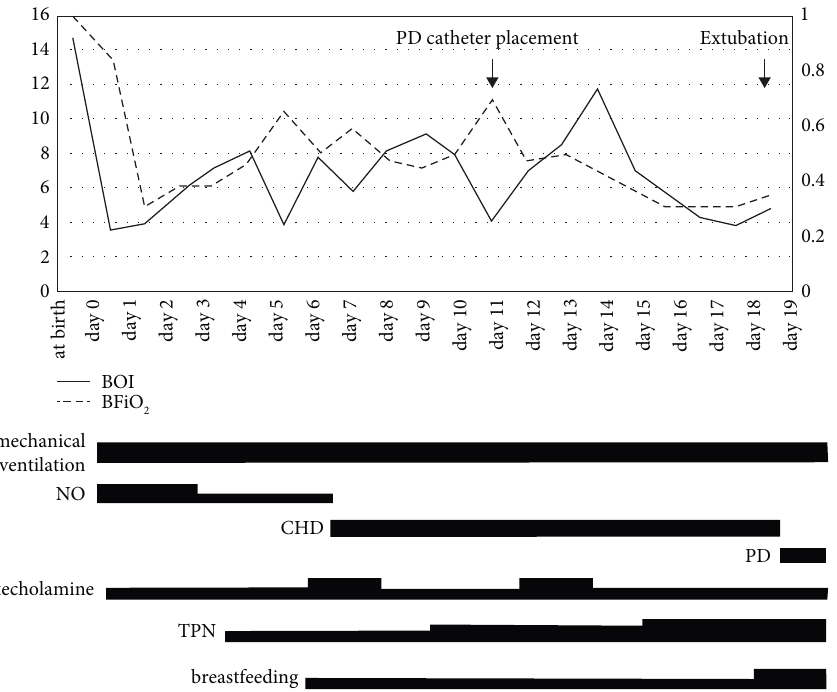
Figure 1: Clinical course immediately after birth. After birth, the patient underwent tracheal intubation and was mechanically ventilated. Systemic management with NO and catecholamines gradually improved OI and FiO 2 . At 5days of age, NO was terminated, and CHD was started. Enteral nutrition started with breast milk at 4days of age, but did not progress, so TPN gradually increased. PD catheter placement was performed at 11days of age. At 18 days of age, CHD was switched to PD and extubated at 19days of age. OI, oxygen index; PD, peritoneal dialysis; FiO 2 , fraction of inspired oxygen; NO, nitric oxide; CHD, continuous hemodialysis; TPN, total parenteral